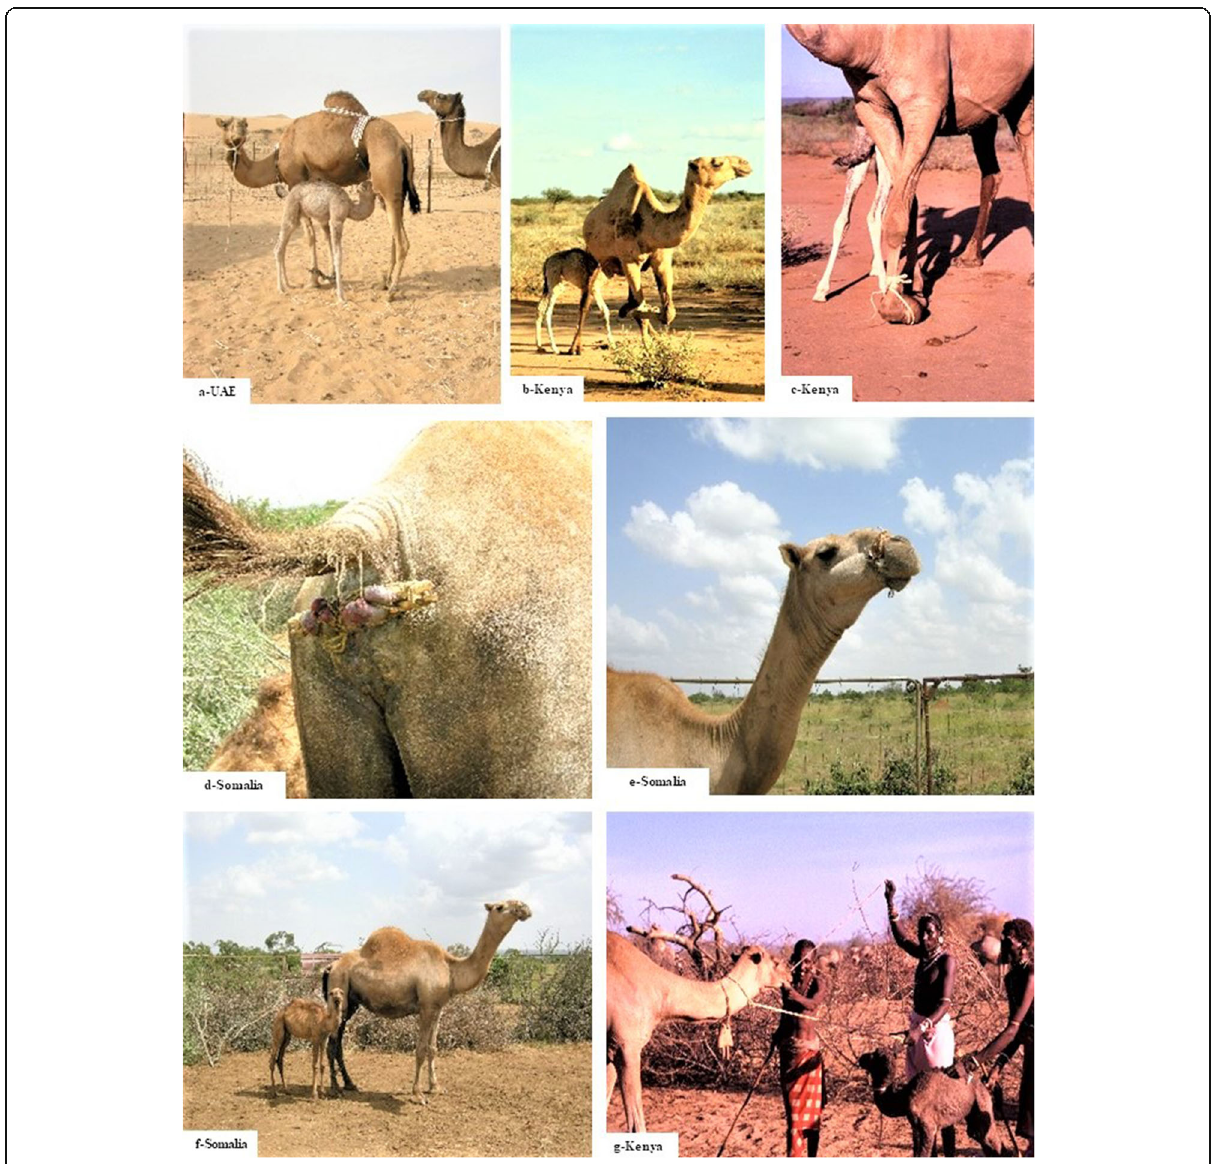
Fig. 9 Images of various camel milking and weaning practices used by nomadic camel pastoralists in a variety of countries (Dioli 2012,2013, Schwartz and Dioli 1992). a UAE. b , c , g Kenya. d – f